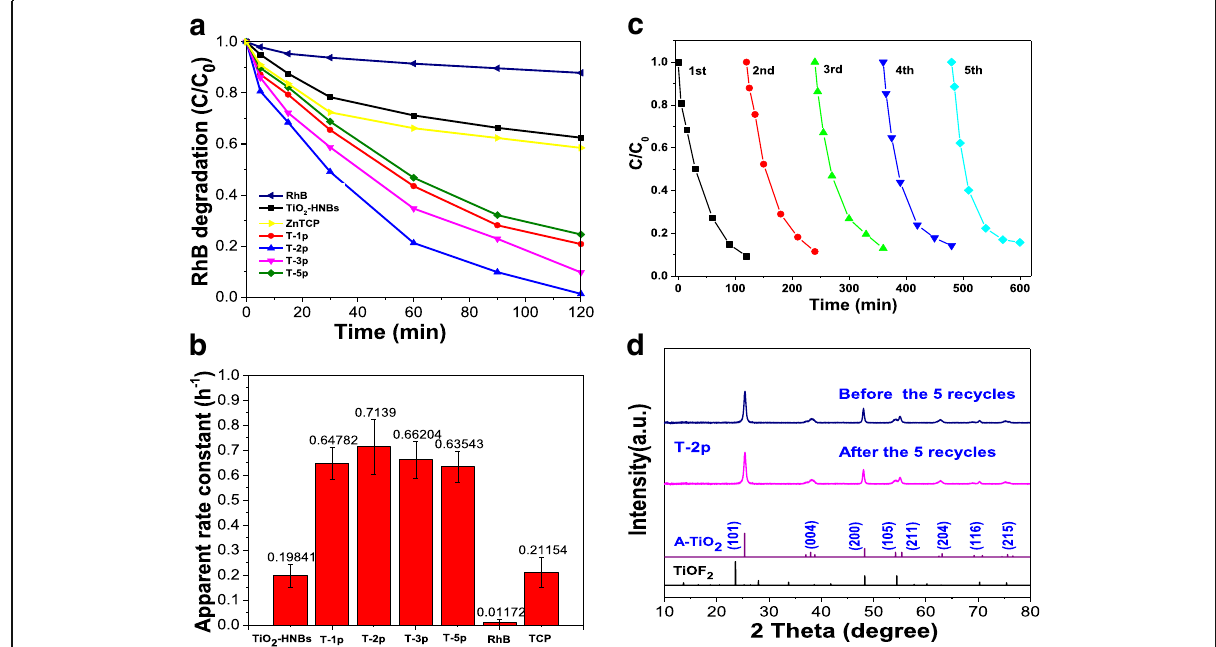
Fig. 8 a The C t /C 0 vs. time curves of RhB photodegradation under visible-light irradiation. b The apparent first-order rate constant of RhB photodegradation. c Cyclic degradation curve of T-2p. d The XRD before and after recycles of